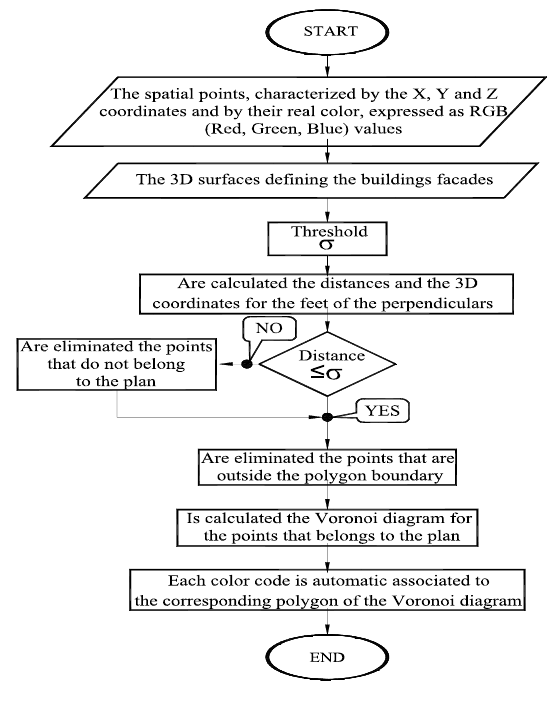
Figure 3. The proposed algorithm logical